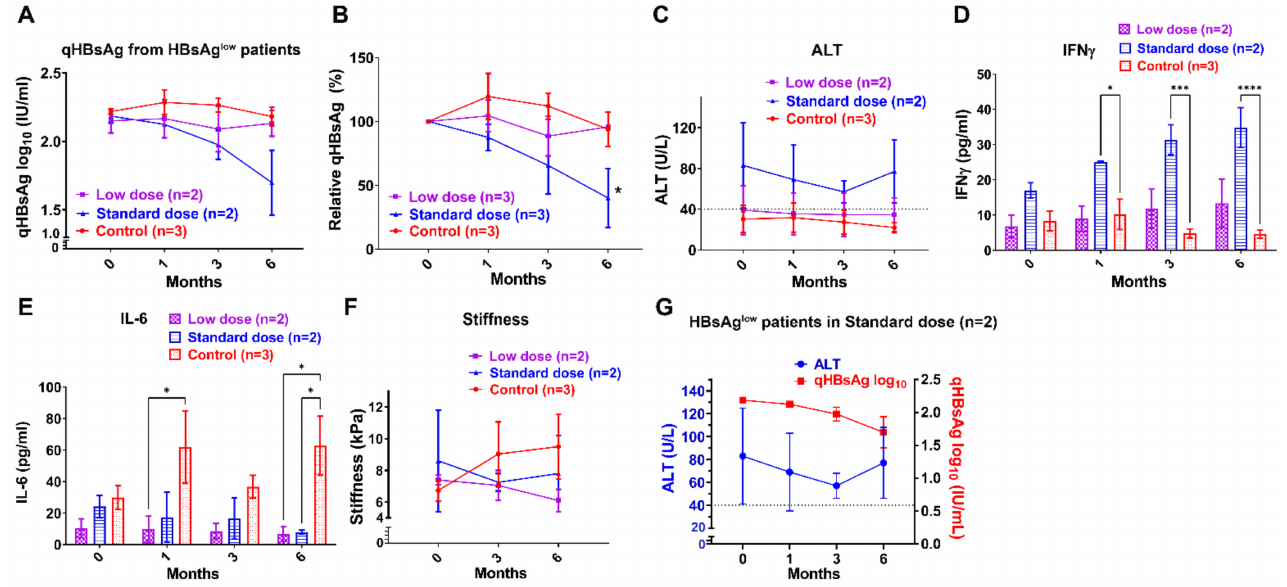
Figure 3. Arthrospira reduces serum qHBsAg and enhances serum IFN- γ level in qHBsAg low patients receiving NA treatment. ( A ) The graph demonstrates the change in serum HBsAg quantity (qHBsAg) log 10 (IU/mL) in patients in the three groups over 6 months. ( B ) The graph demonstrates the change from baseline of qHBsAg in patients in the three groups over 6 months. The qHBsAg level at 0 months (before Arthrospira supplement) was as the baseline level of each patient in graph B. A reduction in qHBsAg and significant reduction in relative qHBsAg levels were observed in the standard-dose group. (* p < 0.05, compared to control). qHBsAg low patients:HBeAg( − ) patients with